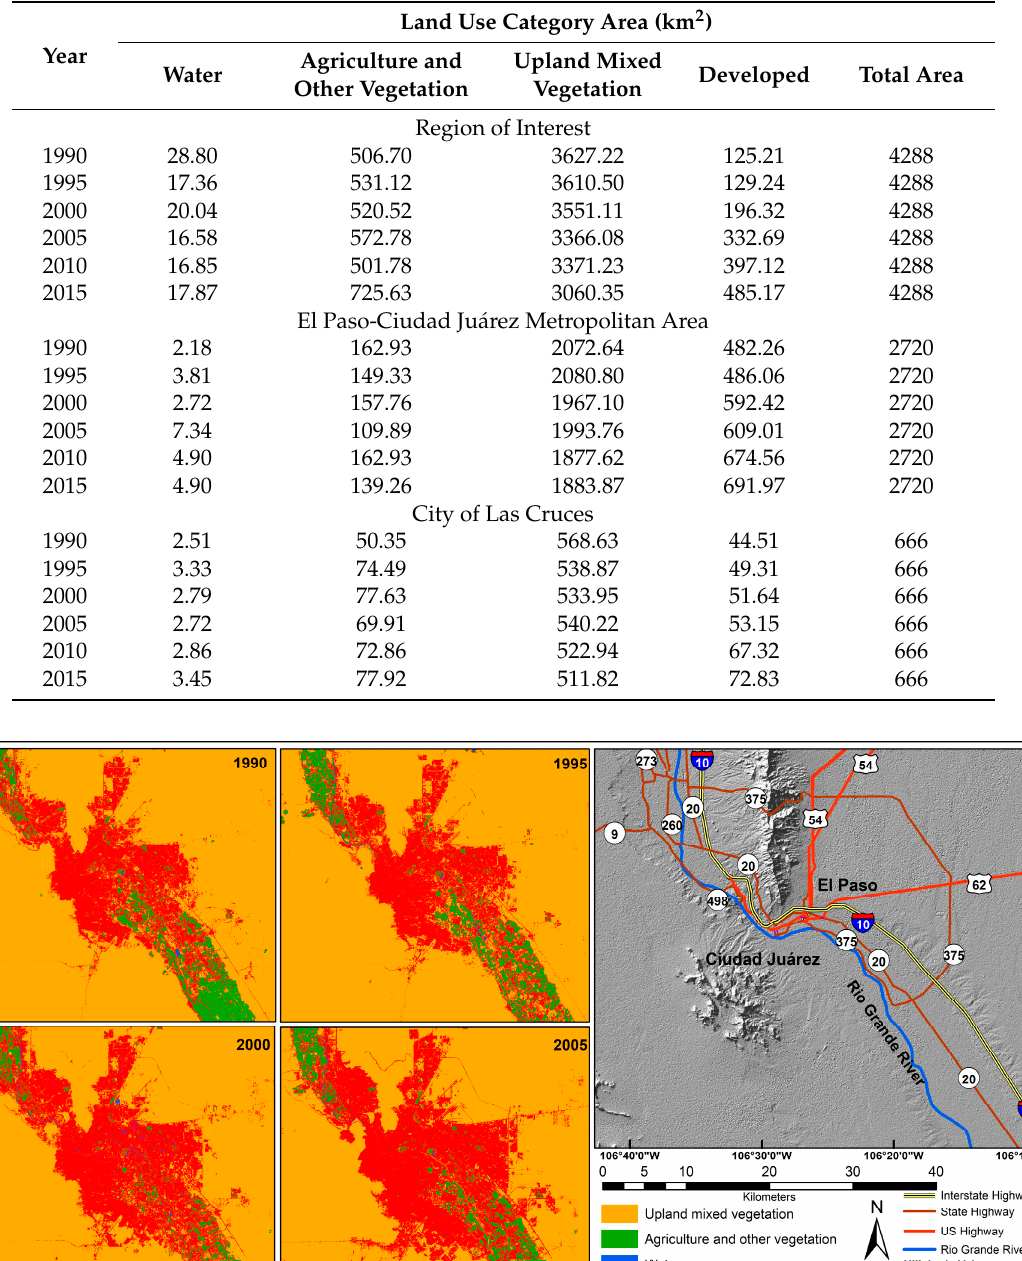
Table 4. Land use quantification results for region of interest and urban areas.